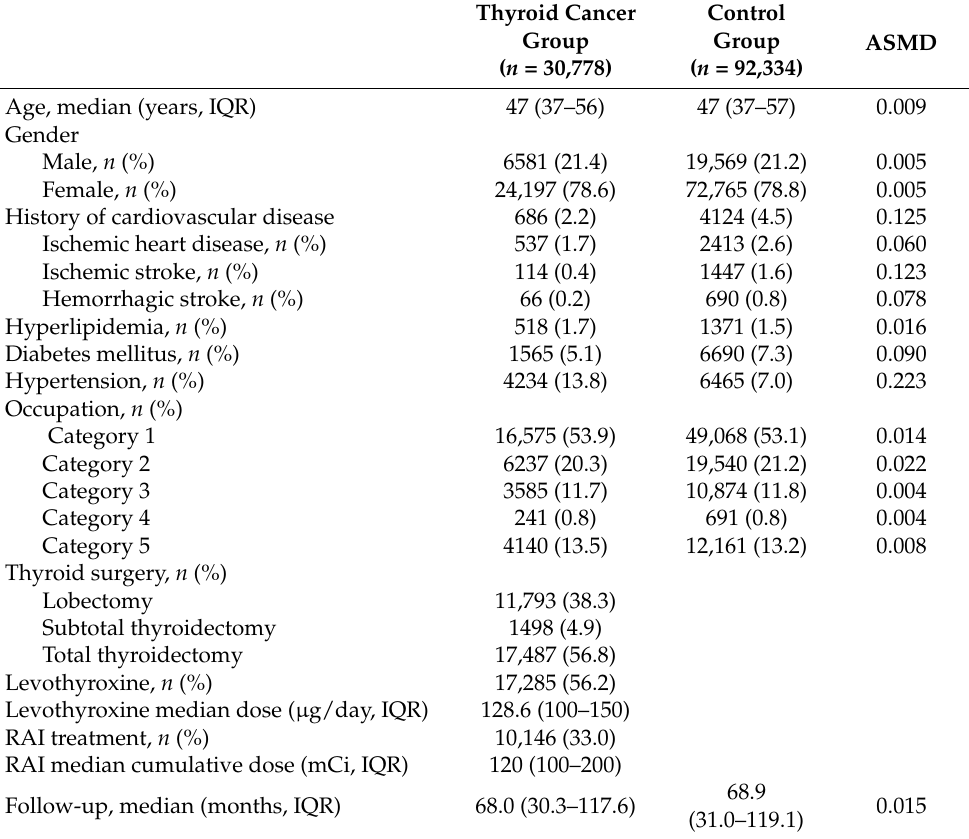
Table 1. Characteristics of the study